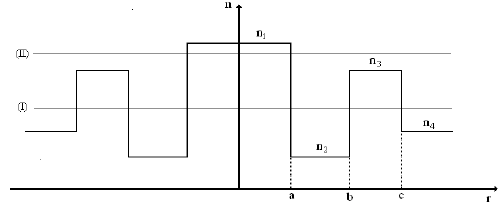
Figure 1. The index of refraction profile for the proposed structures (WII). According to LP approximation to calculate the electrical field distribution, there are two regions of operation and the guided modes and propagating wave vectors can be obtained by using two determinants which are constructed by boundary conditions [13]. The two lines drown in Figure 1 demonstrate these two operation